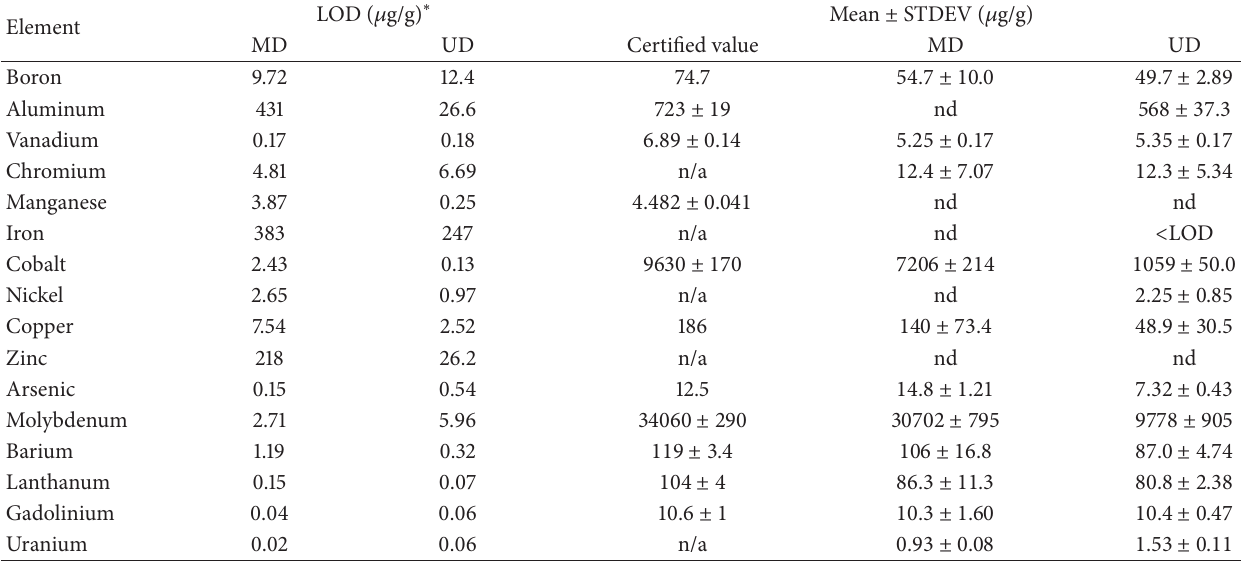
Table 3: Metal concentrations of NIST 2483-CNT with microwave digestion (MD) and ultrasonic digestion (UD) methods in the presence of GhostWipes. The results are presented as mean ( 𝜇 g/g) and standard deviation of five independent determinations (nd = not detected due to blank correction; < LOD = below detection limit; n/a = not